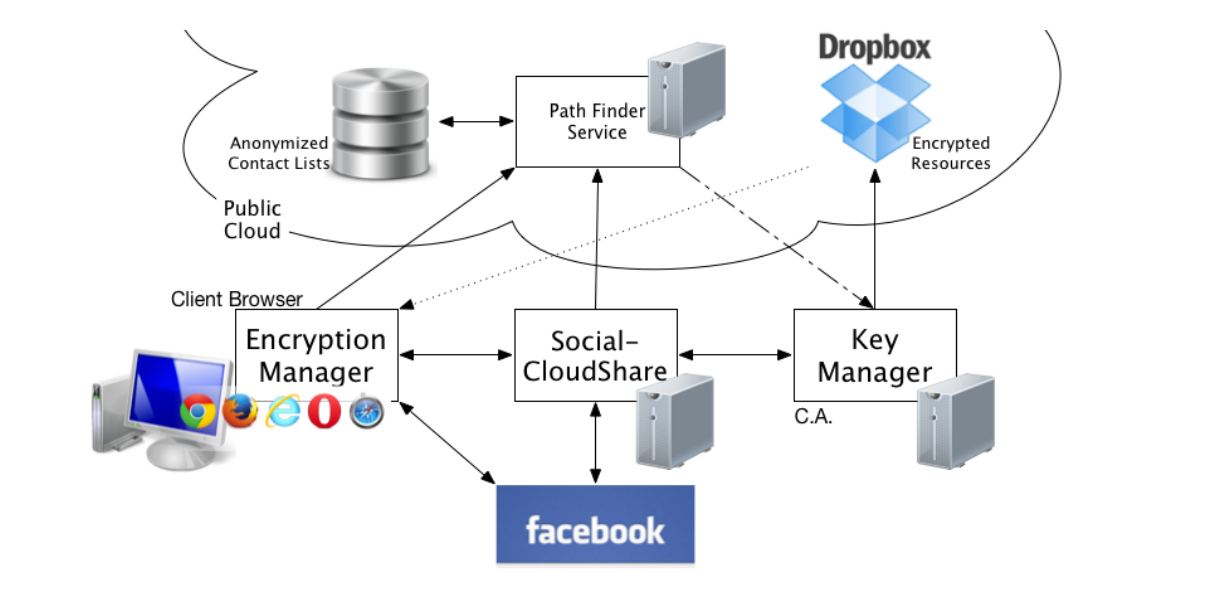
Figure 6. Framework